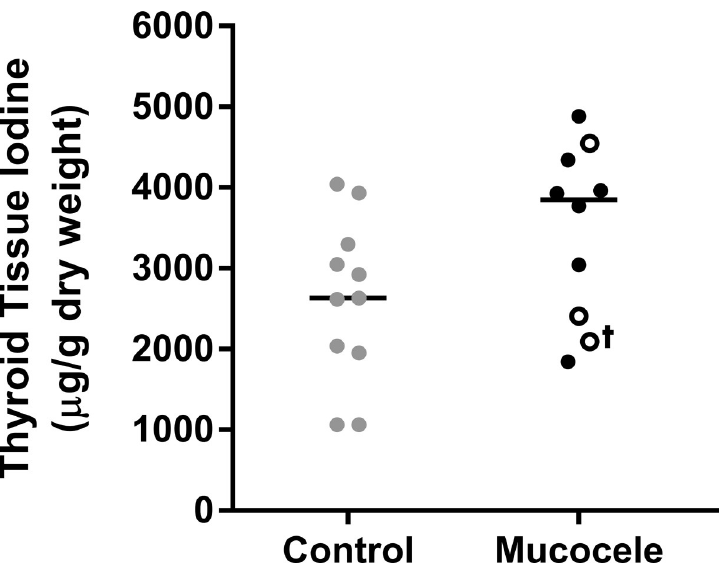
Fig 6. Thyroid iodine content of control dogs and dogs diagnosed with gallbladder mucocele formation. Among dogs with gallbladder mucocele formation, open circle data points represent 3 dogs that had concurrent thyroid hormone assay testing. † serum total T4 and total T3 were below reference range. Bars =